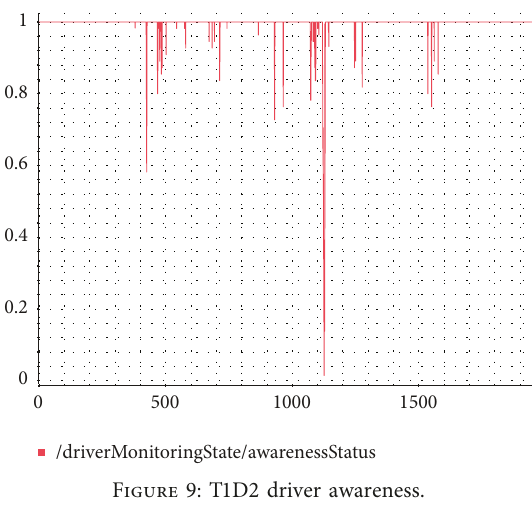
Figure 9: T1D2 driver awareness.